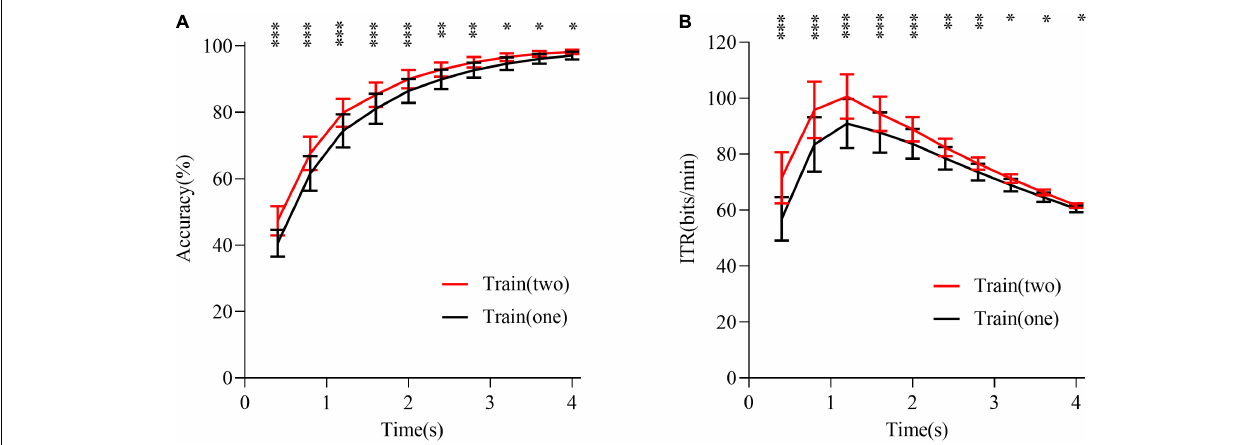
FIGURE 9 | Performance comparison of the Train (one) and Train (two). (A) Accuracy. (B) ITR value. Train (one) means that data of one of the three experiments were used for training, and data of the other two experiments were used for testing; there were six cases in total. Train (two) means that data of two of the three experiments were used for training, and data of the remaining experiment were used for testing; there were three cases in total. The asterisks indicate a difference between Train (one) and Train (two) in the paired t -test (* p < 0.05, ** p < 0.01, and *** p <